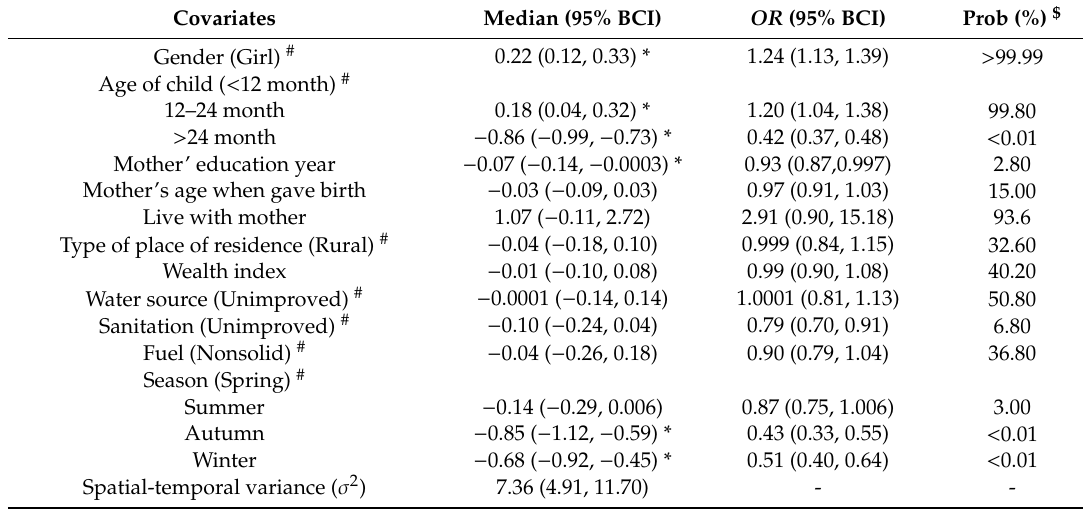
Table 5. Posterior summaries of the final Bayesian spatial-temporal model